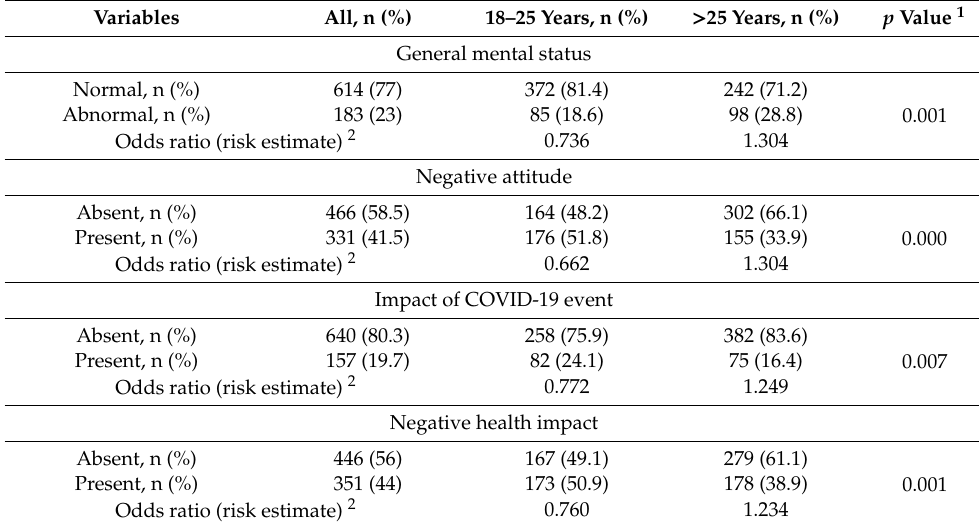
Table 2. General mental status, negative attitude, impact of event scale (IES), negative health impact by age.